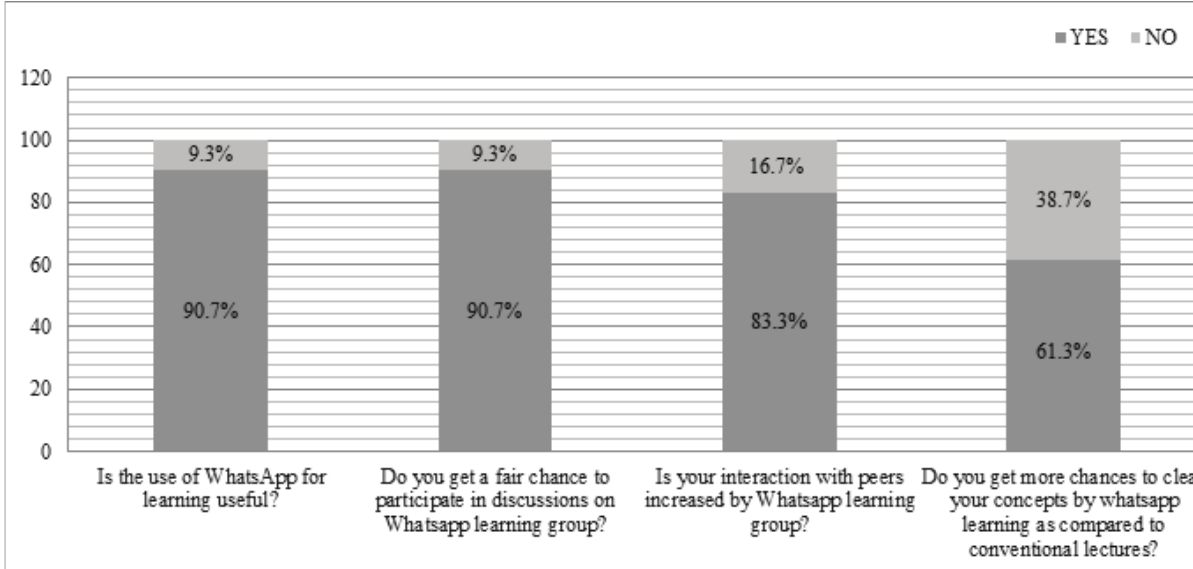
Figure-II: Students' perception of the academic aspect of